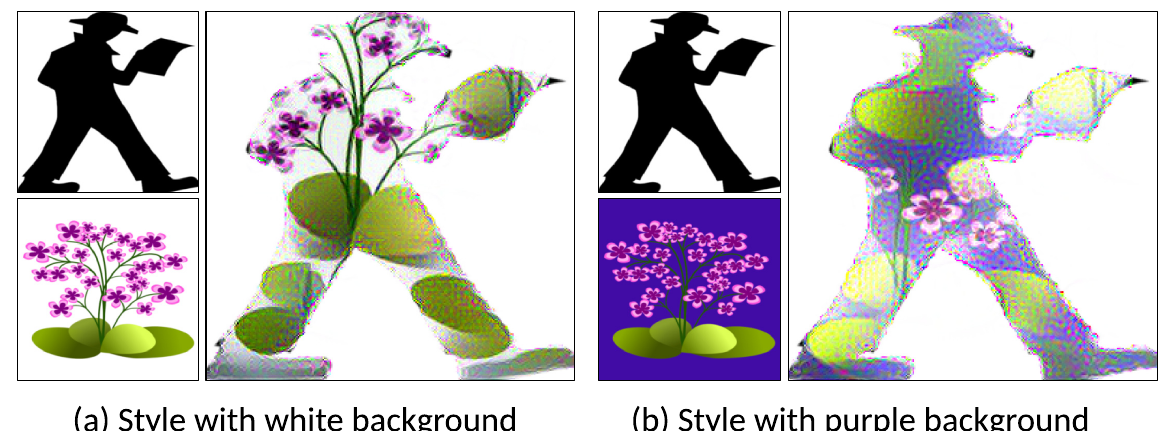
Fig 15. White background style image vs colored background image.